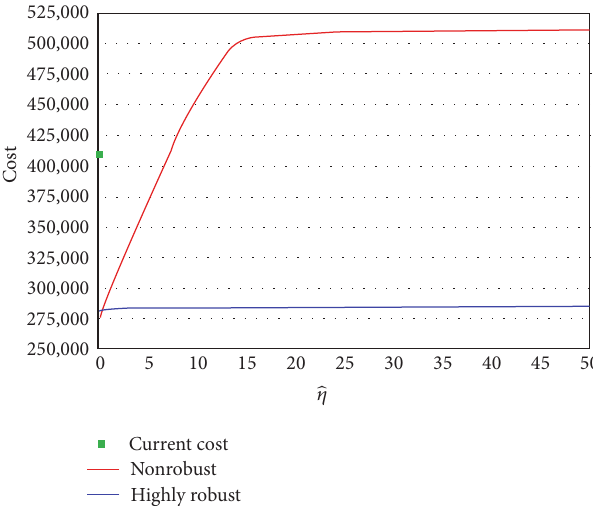
Figure 6: Range of potential cost values for nonrobust and highly robust